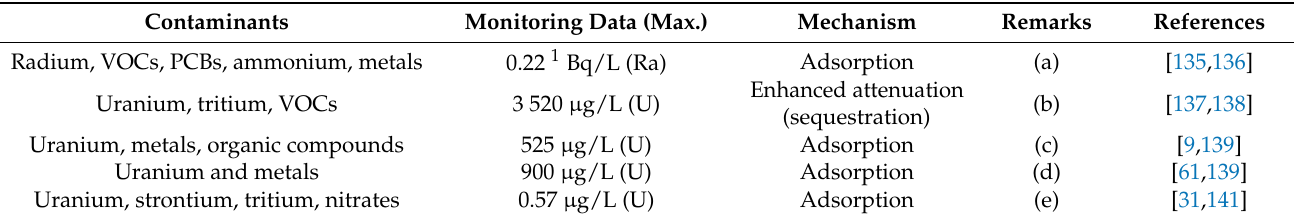
Table 7. Summary of the monitored natural attenuation (MNA) performance for uranium and radium removal. Contaminants Monitoring Data